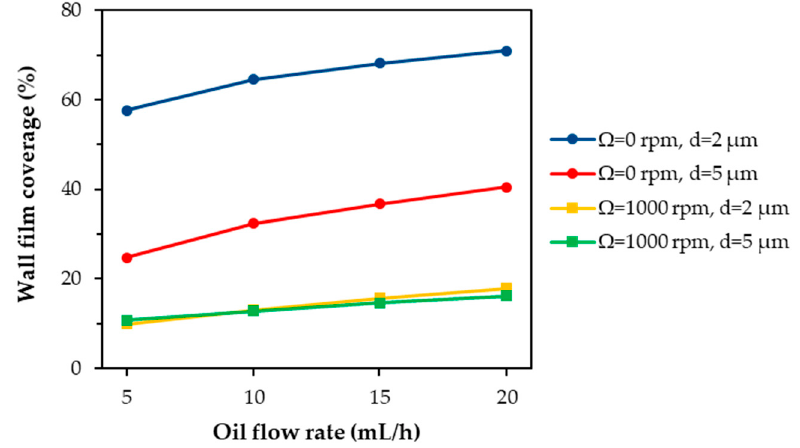
Figure 5. Channel wall film coverage as a function of the oil flow rate: each curve corresponds to one of the four possible combinations of the values of the drill bit rotational speed Ω and oil droplet diameter d at the channel inlet.